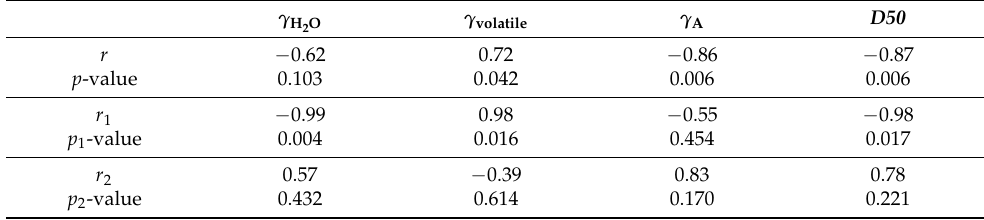
Table 6. Statistical analysis of normalized average of Combustion